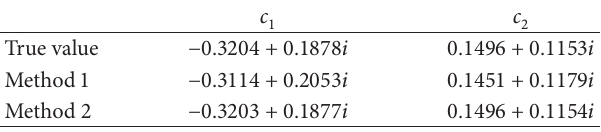
Table 2: Mutual coupling estimates (SNR = 30 dB, 𝐾 = 1000 ).